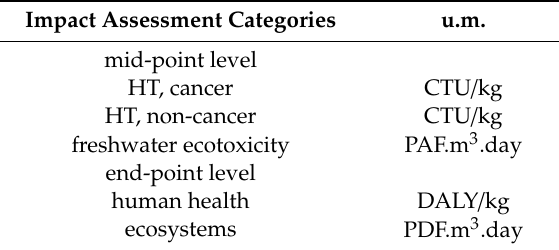
Table 5. USEtox impact assessment categories.